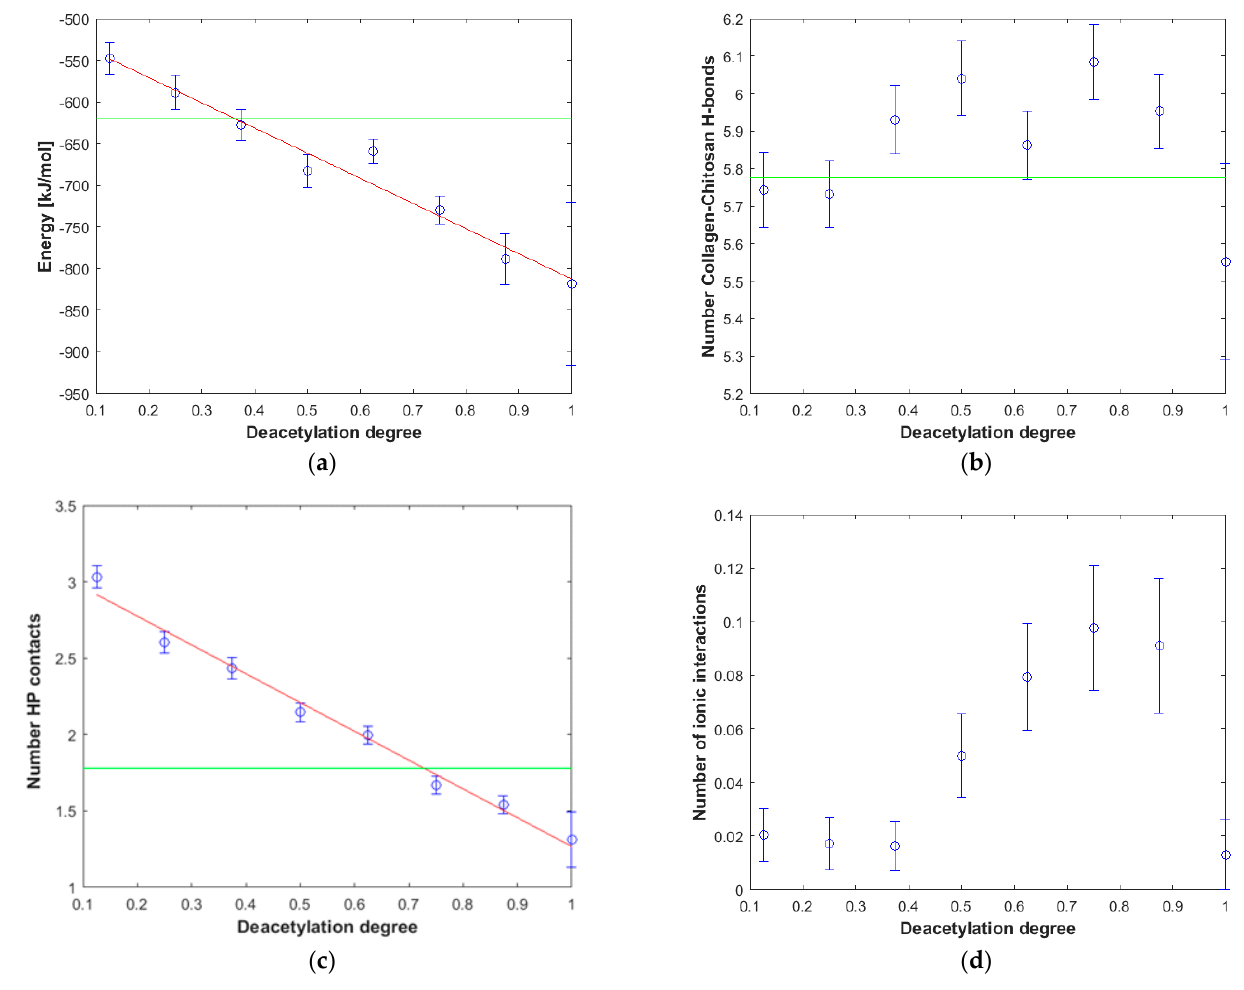
Figure 4. The influence of deacetylation on the stability and selected structural features of collagen– chitosan complexes. ( a ) Affinity energy vs. deacetylation degree (DD) of chitosan. ( b ) Number of intermolecular H-bonds vs. deacetylation degree (DD) of chitosan. ( c ) Number of intermolecular hydrophobic (HP) interactions vs. deacetylation degree (DD) of chitosan. ( d ) Number of intermolecular ionic interactions vs. deacetylation degree (DD) of chitosan. The green line represents the average affinity energy value determined for the collagen-HA system.